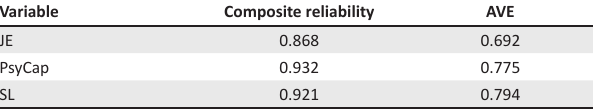
TABLE 4: Quality criteria (outer model).